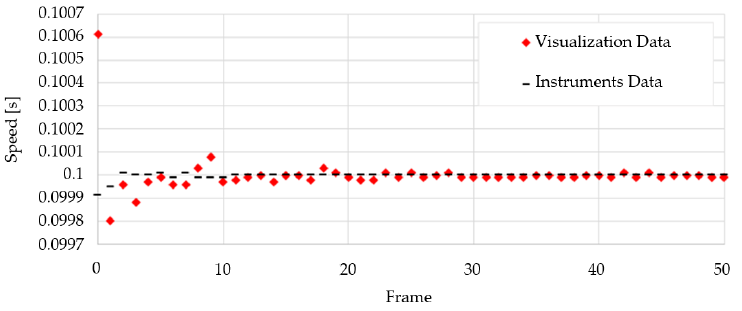
Figure 14. Speed of drawing the vessel’s positioning on our visualization